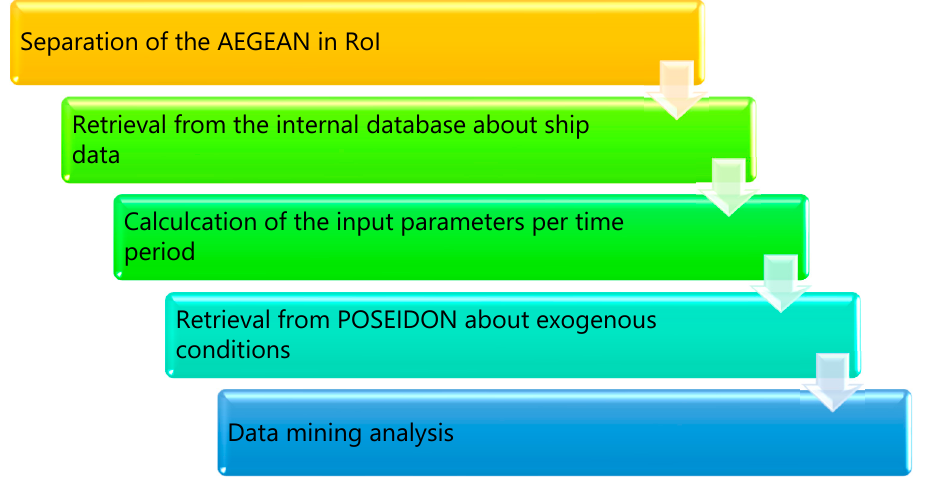
Figure 3. The data preprocessing process.